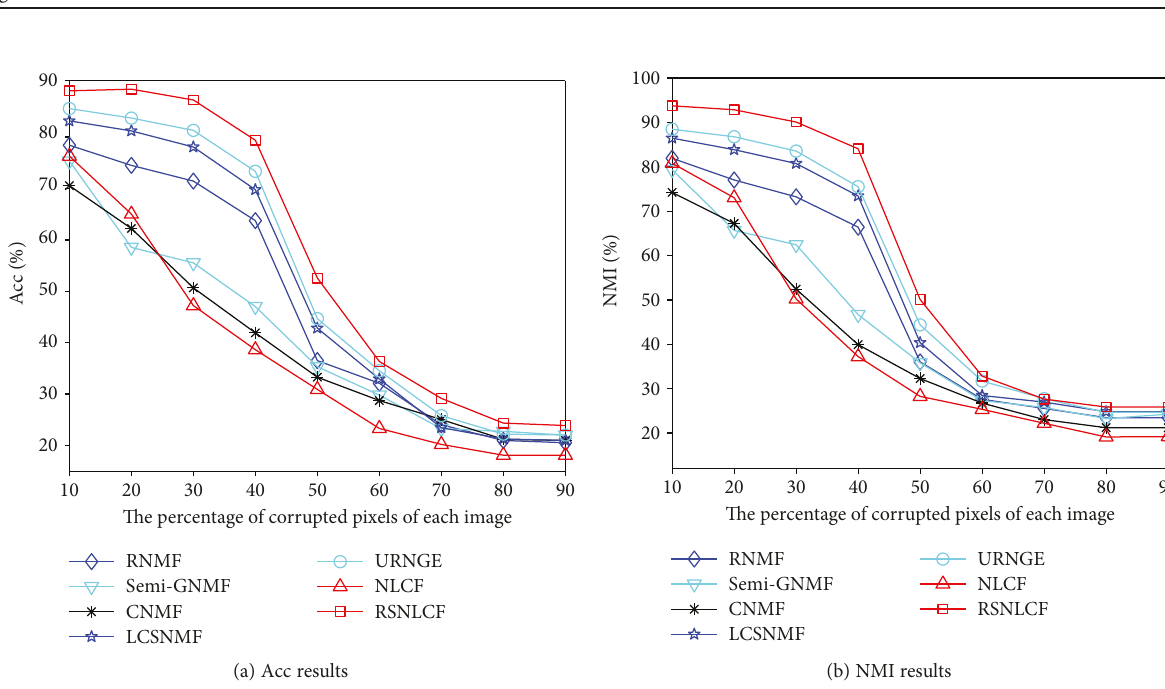
Figure 2: Clustering Acc and NMI curves across percentages of corrupted pixels of each image for the compared methods on the ORL